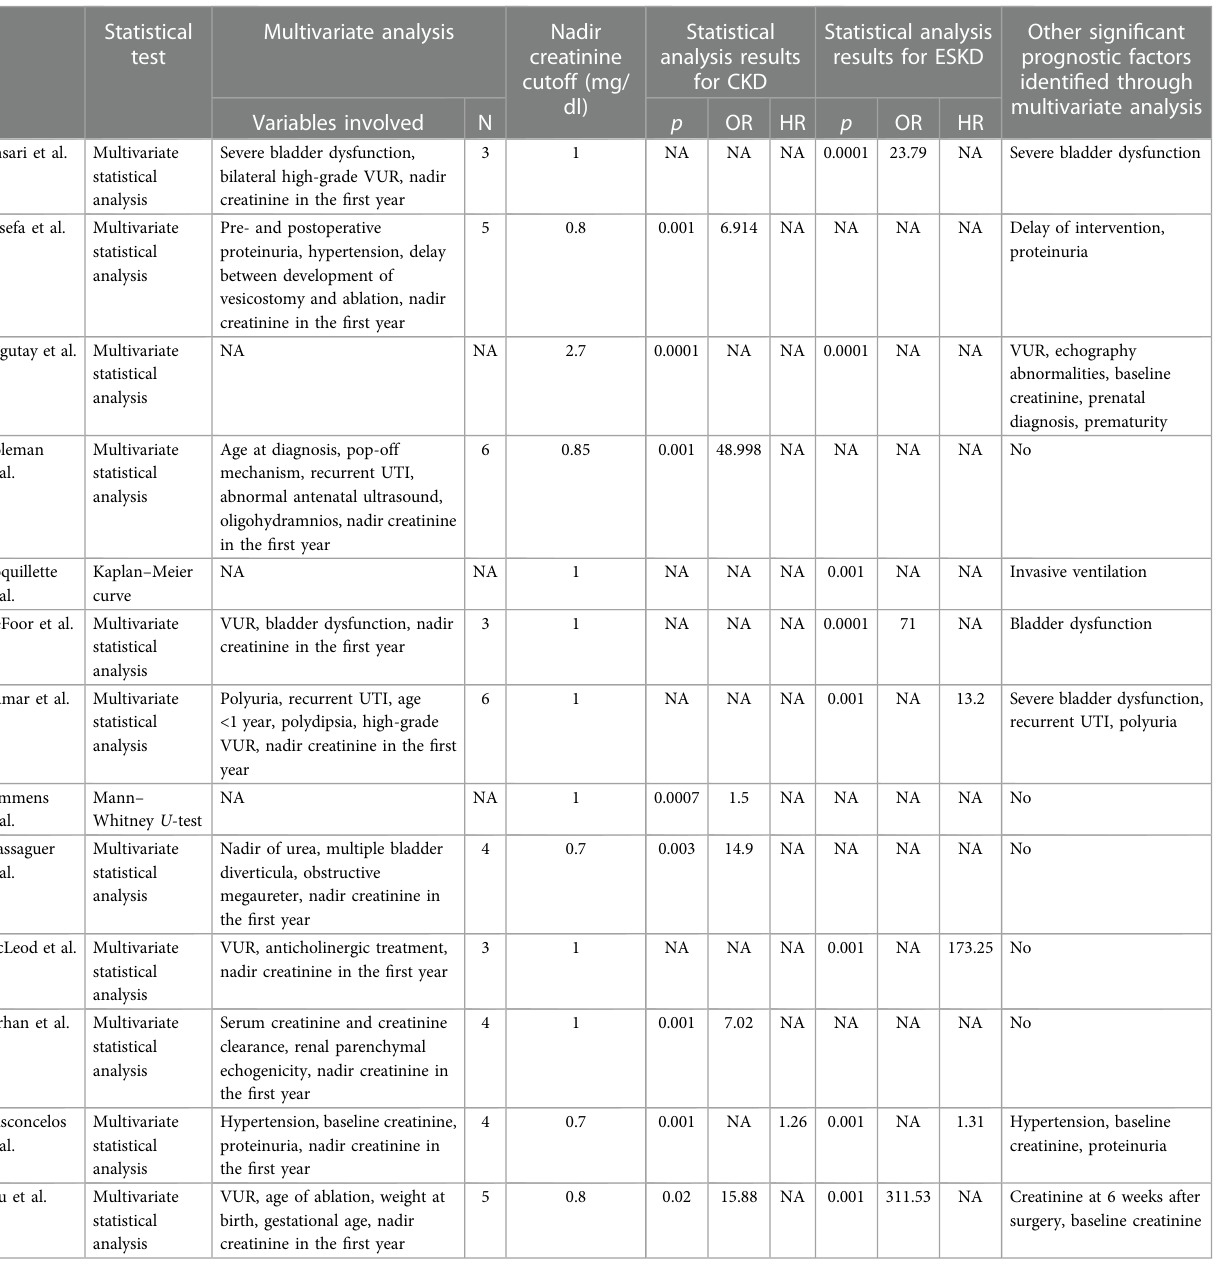
TABLE 3 Main results of studies included in the systematic review and